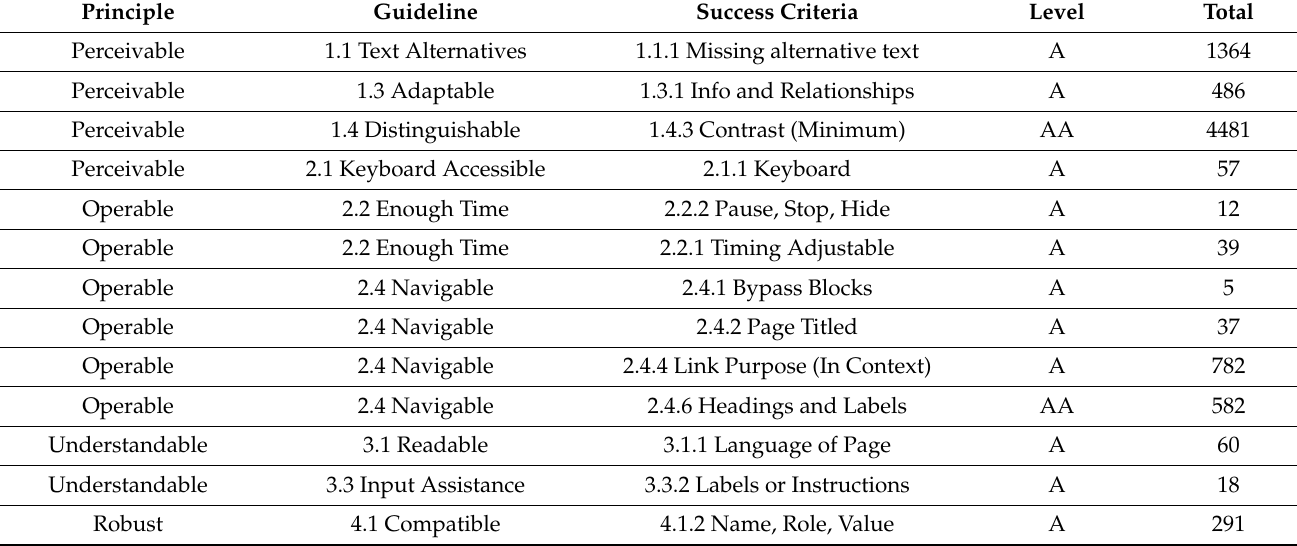
Table 5. Accessibility guidelines that were identified in the study.